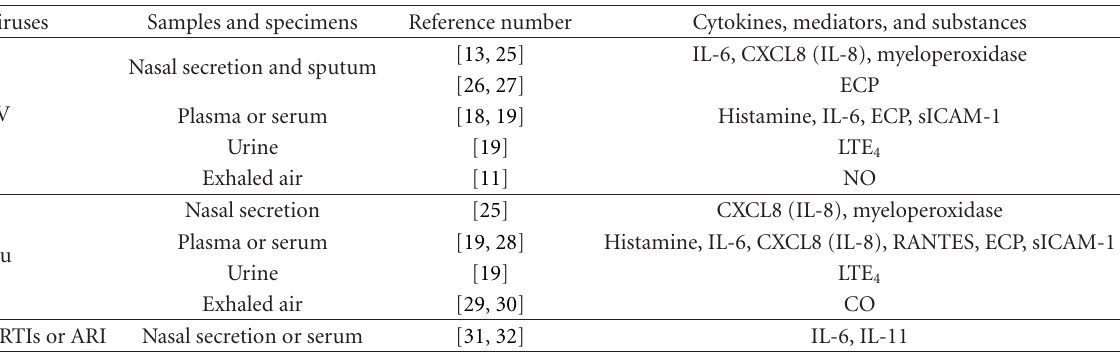
Table 1: Cytokines, mediators, and substances induced by virus